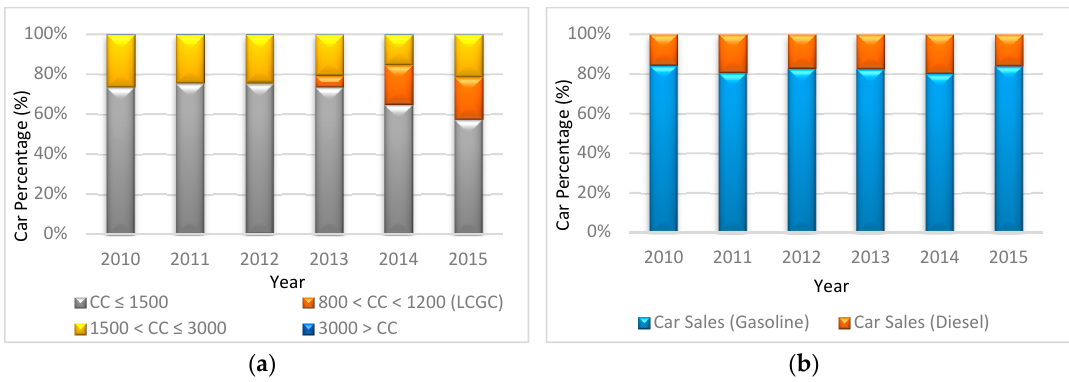
Figure 6. Shares of car sales by ( a ) engine size (gasoline cars) and ( b ) engine type.